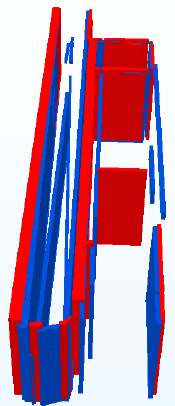
Figure 3. Example of corridor reconstruction without (blue) and with (red) spatial reasoning applied.